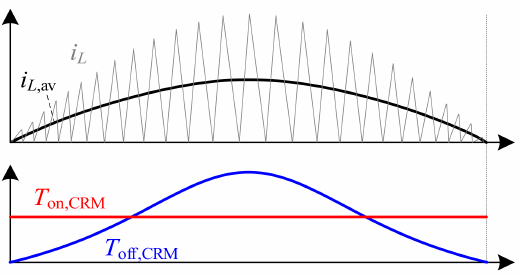
Figure 3. Constant on-time to achieve CRM operation and sinusoid i L ,av